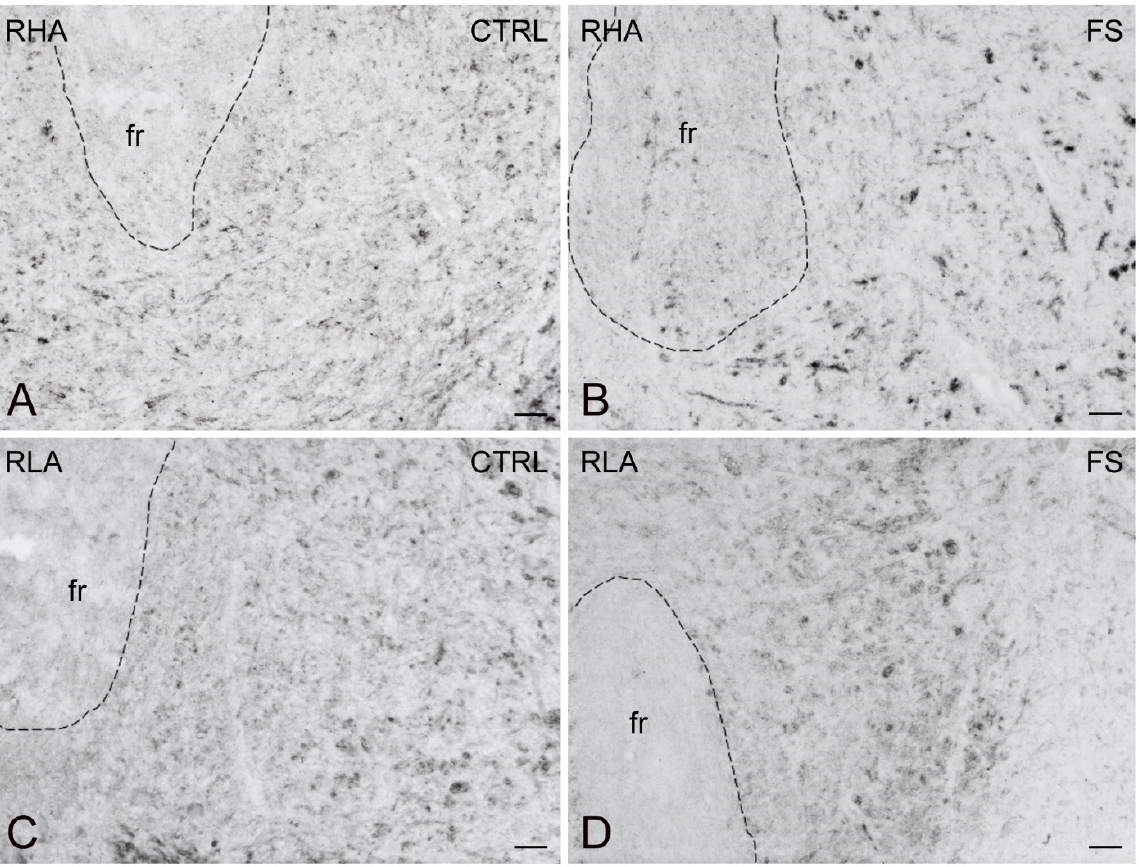
Figure 7. Brain-derived neurotrophic factor-like immunoreactivity (BDNF-LI) in the ventral tegmental area (VTA) of RHA ( A , B ); and RLA rats ( C , D ) under baseline condition (CTRL) and after a 15 min session of forced swimming (FS). fr, fasciculus retroflexus. Scale bars: 25 µm.